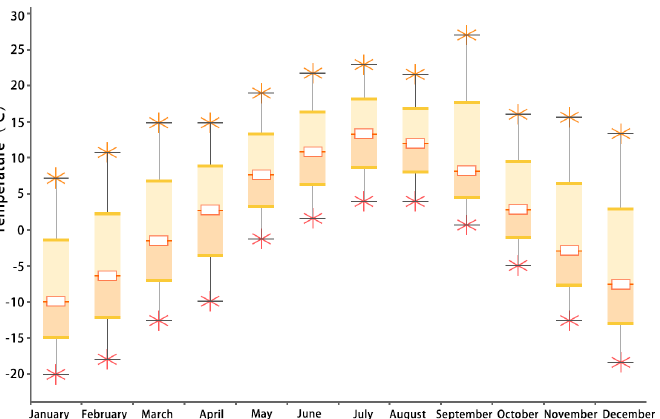
Figure 4. Box plot of monthly average temperature in the Xiahe County (source: Ecotect).